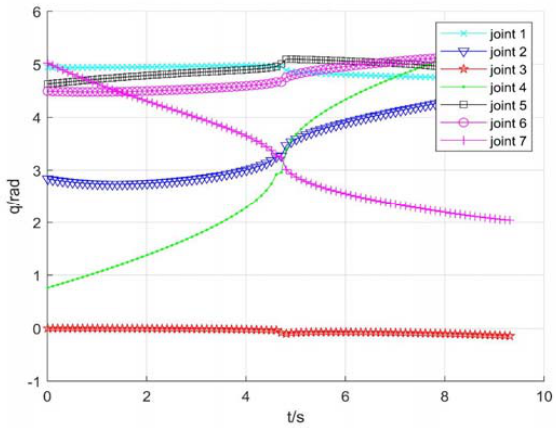
Figure 11. Velocity of each joint.